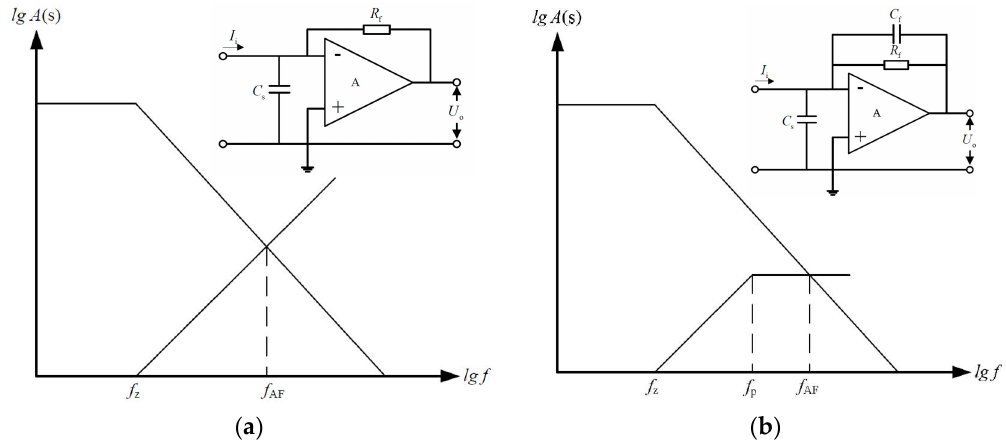
Figure 5. The amplitude frequency response of the open loop gain and the noise gain. ( a ) Amplifier without lead correction. ( b ) Amplifier with lead correction.